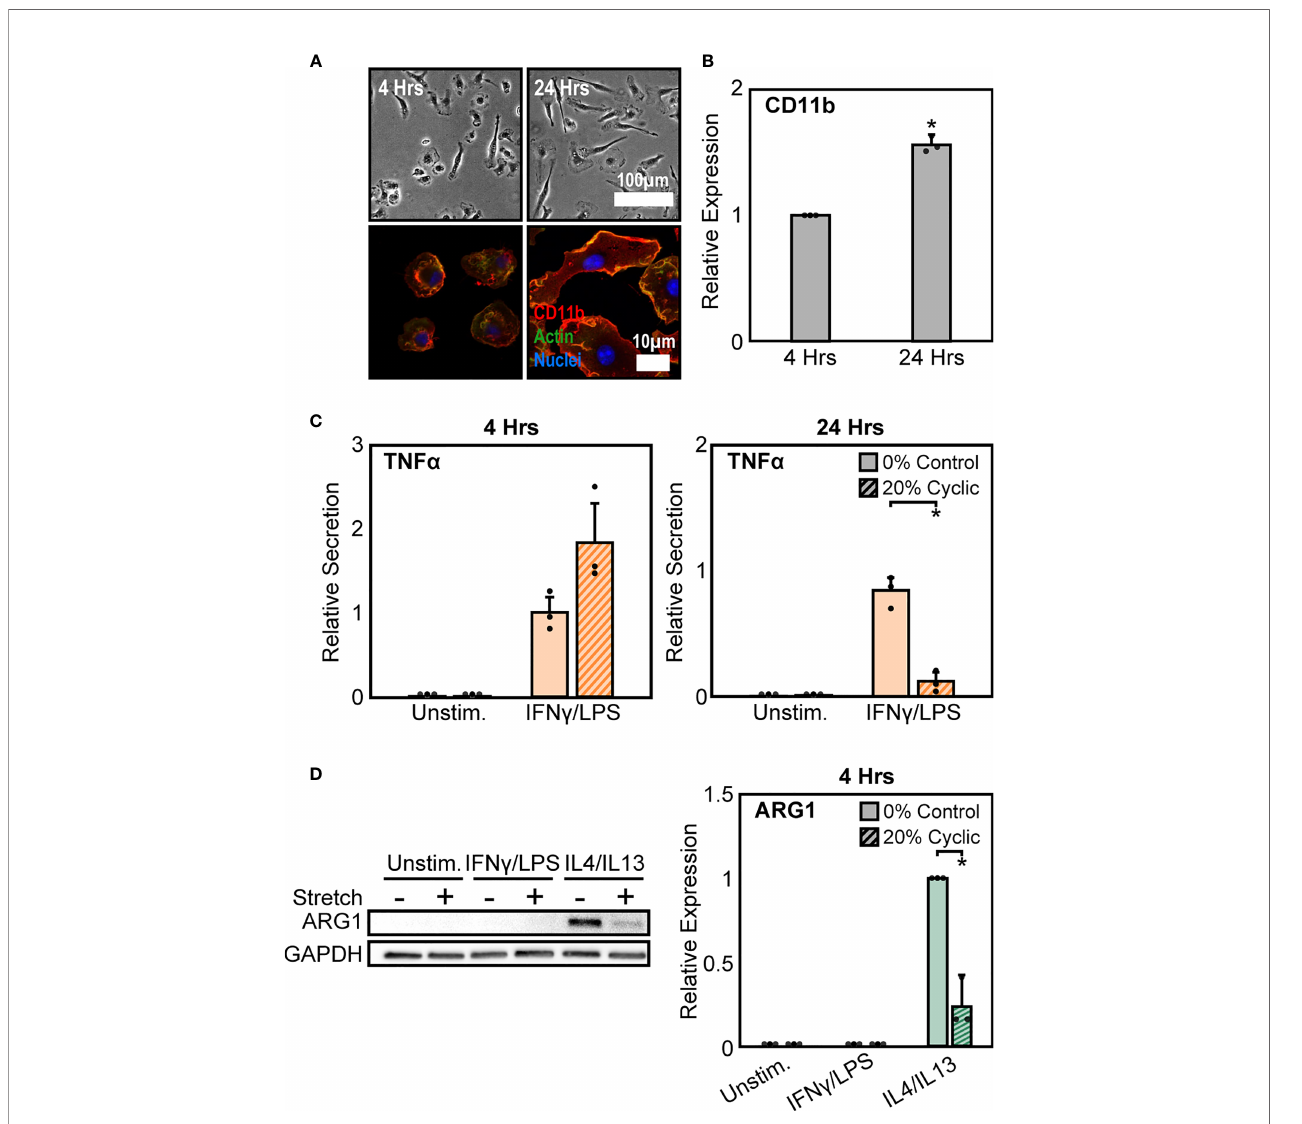
FIGURE 4 | Modulation of CD11b by adhesion time regulates stretch-mediated macrophage in fl ammatory responses. (A) Phase contrast images (top) of macrophages following 4 hrs (left) and 24 hrs (right) of adhesion prior to stimulation and stretch. Fluorescence images (bottom) of macrophages labelled for CD11b (red), actin (green), and nuclei (blue) following 4 hrs (left) and 24 hrs (right) of culture. (B) Averaged relative median fl uorescence intensity across three independent experiments of CD11b as measured by fl ow cytometry. Values normalized to 4 hrs adhesion condition. (C) Secretion of TNF a for unstimulated and IFN g /LPS stimulated macrophages exposed to 0% and 20% cyclic stretch after 4 hrs (left) and 24 hrs (right) of adhesion. Values are normalized to a 0% stretch IFN g /LPS internal control within each biological replicate. (D) Representative Western blots (left) and corresponding quanti fi cation for ARG1 (right) for unstimulated, IFN g /LPS, and IL4/IL13 stimulated macrophages allowed to adhere for 4 hrs prior to stimulation and stretch. Values were normalized to GAPDH and made relative to IL4/IL13 stimulated and 0% stretch conditions, respectively. Error bars indicate standard deviation of the mean for three separate experiments and * p < 0.05 when compared to the corresponding 0% stretch condition as determined by Student ’ s t-test (C) or paired t-test (B, D)